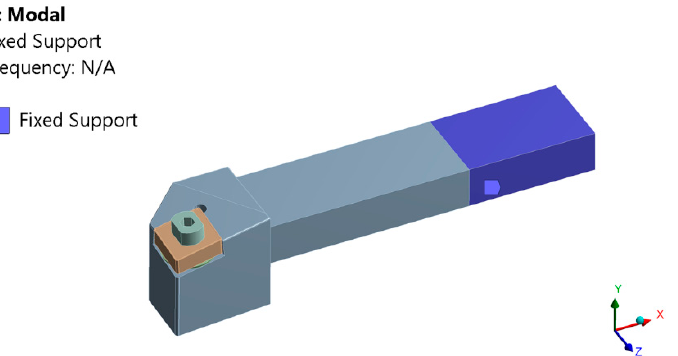
Figure 6. The constraints imposed on the T02 tool to perform the analysis of its own vibration modes